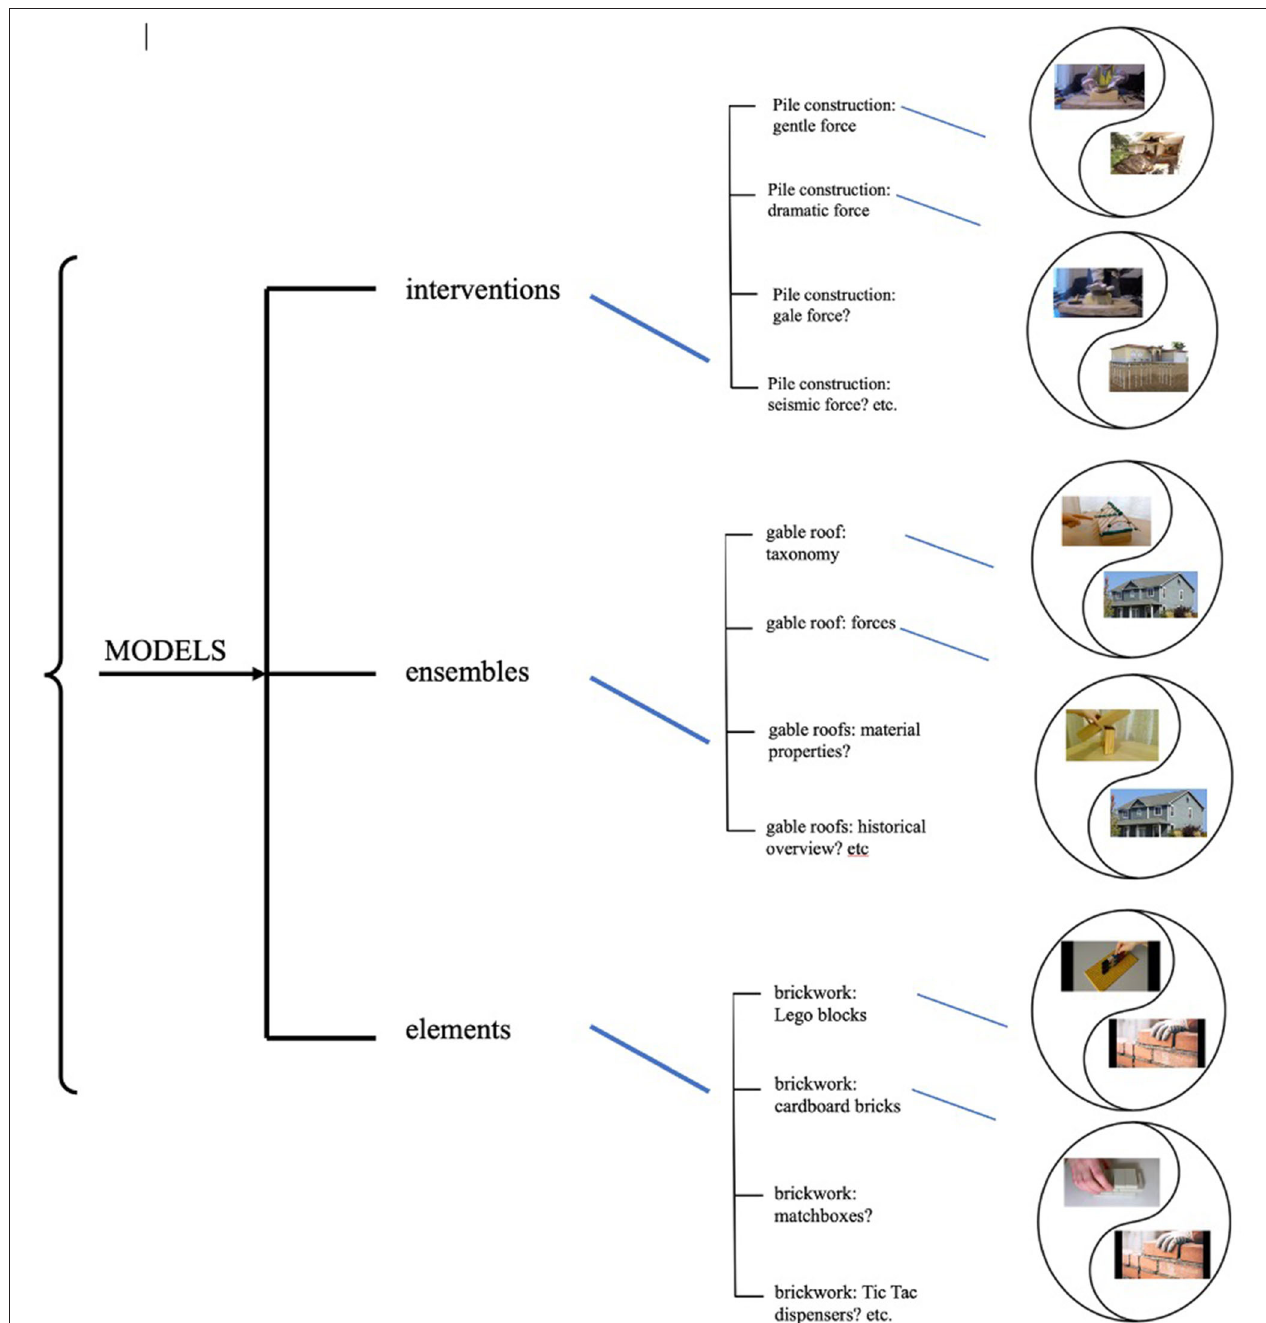
FIGURE 2 | The system of models with realization